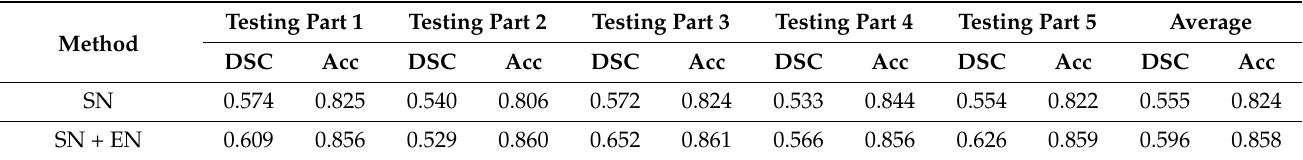
Table 5. Performance comparisons with or without enhancement network on the TDID